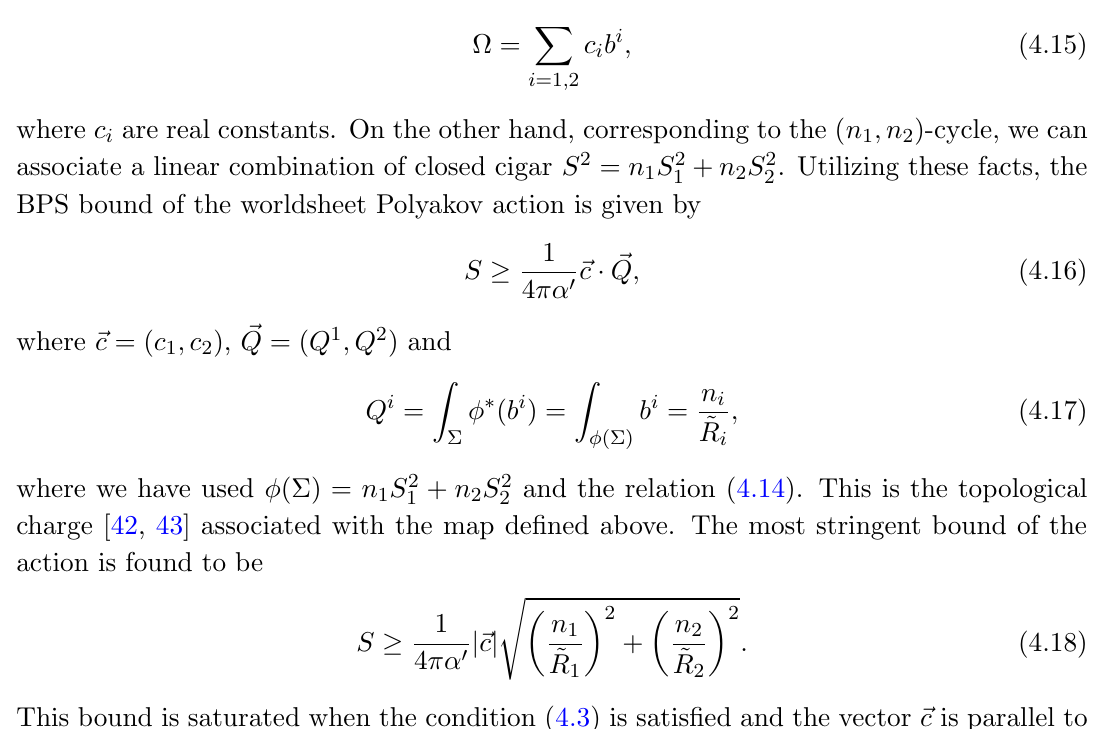
Here ~ R i are constants. Then the K(cid:127)ahler form (cid:10) is expanded